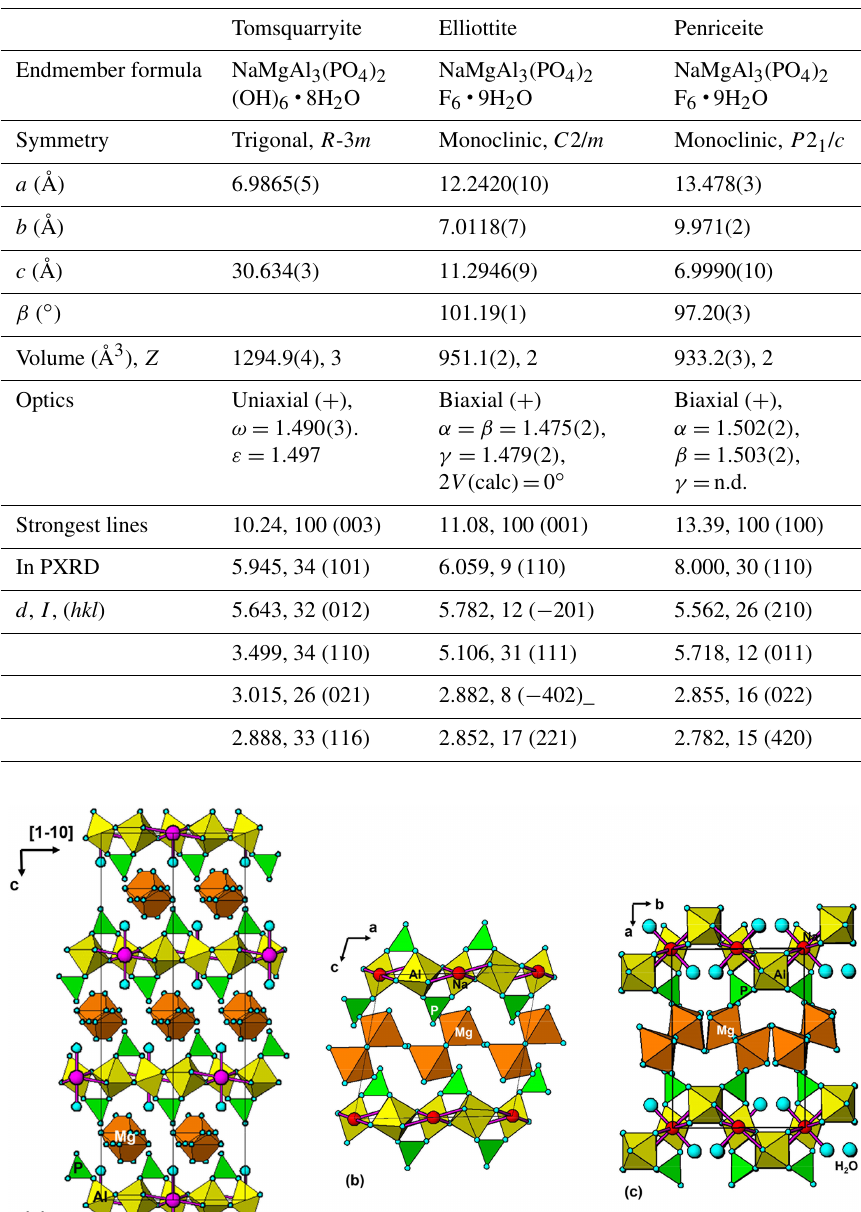
Table 6. Comparison of properties for tomsquarryite, elliottite and penriceite.